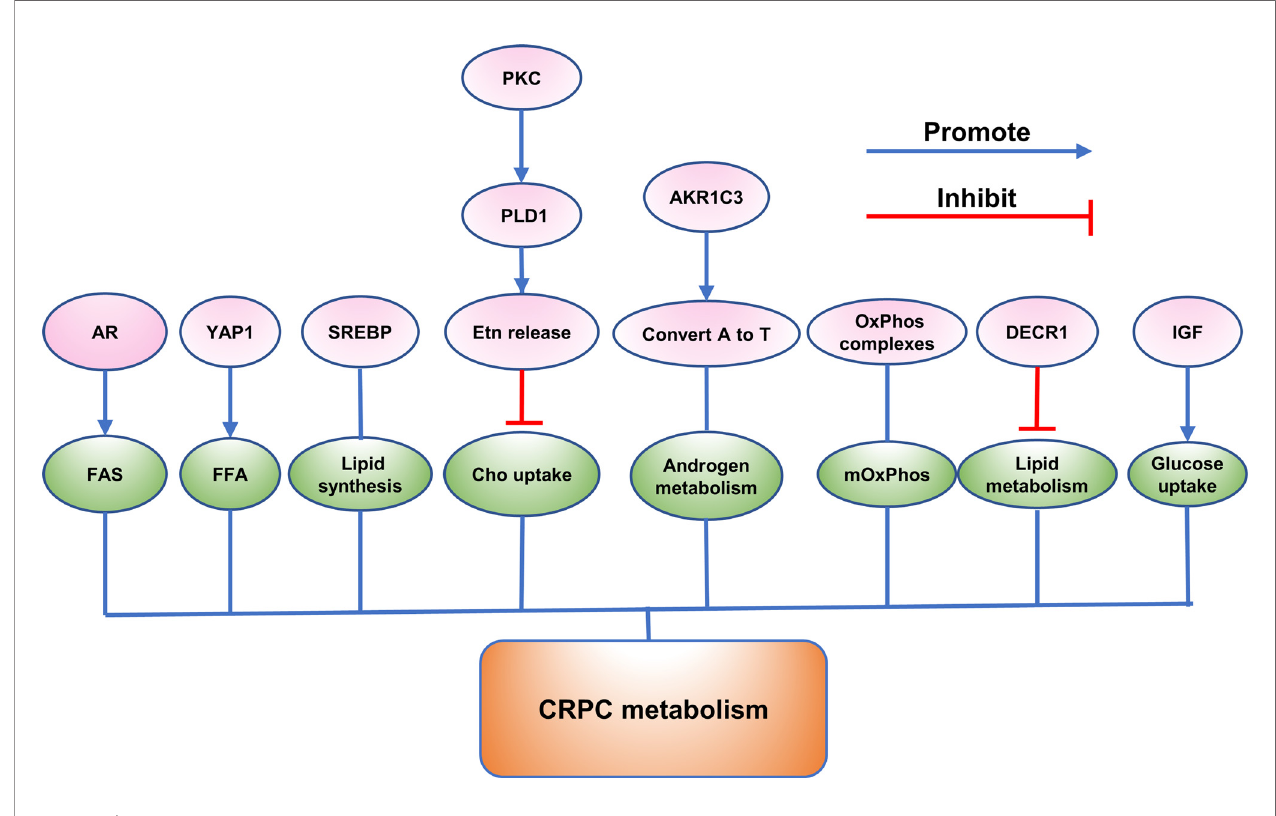
FIGURE 2 | The role of emerging proteins in CRPC metabolism.